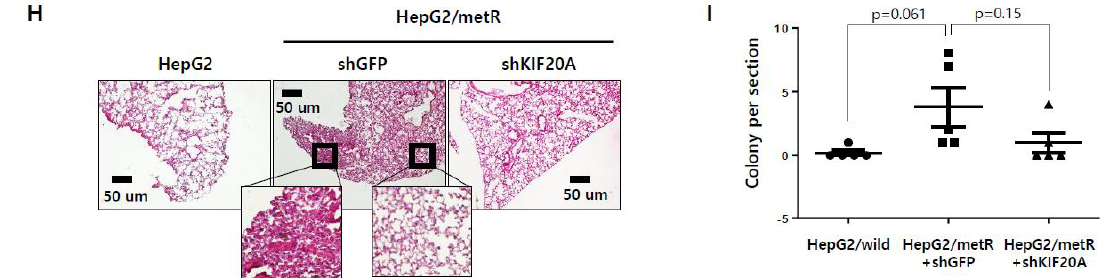
Figure 5. Lactate-induced cell motility is closely associated with E2F1-mediated activation of kinesin family genes and regulation of microtubule dynamics. ( A ) E2F1-dependence of the mRNA expression of 5 different microtubule-associated kinesin family genes was quantitatively evaluated in control and E2F1-depleted HepG2/metR cells. For qRT-PCR the expression level of transcripts for each gene was normalized by Ct-value of EMC7. Results from three independent experiments are shown as mean ± SD. The p -value was assessed by Student’s t -test. * p < 0.05 and ** p < 0.01 vs. control. ( B ) Migration and invasion assays to examine the effects of kinesin family gene depletion on the motility of HepG2/metR cells. Original magnification (40 × ). ( C ) Immunofluorescence imaging of α -tubulin protein (green) to examine the effects of kinesin family gene depletion on the tubulin fiber structure in HepG2/metR cells. Experiments were conducted in triplicate, and the data shown represent a typical experiment. ( D ) Overall survival and disease-free survival rates of hepatocellular carcinoma patients depending on the combined expression of KIF2C, KIF18B, and KIF20A in TCGA-LIHC (372 patients) cohort. Hazard Ratios with 95% confidence interval are also shown. ( E ) Immunofluorescence imaging of α -tubulin protein (white) in HepG2/wild cells, and control siRNA-treated, KIF20A-depleted, or oxamate-treated HepG2/metR cells. Experiments were conducted in triplicates, and the data shown represent a typical experiment. ( F ) Correlation analysis between KIF20A expression levels and migration properties in eight different liver cancer cell lines. ( G ) Correlation analysis between KIF20A expression levels and lactate production rates in eight different liver cancer cell lines. The r- and p -values were assessed by Spearman correlation calculation. ( H ) H&E stained sections of lungs isolated from mice that received tail vein injection of HepG2/wild, HepG2/metR+shGFP, and HepG2/metR+shKIF20A cells (scale bar; 50 µ m). ( I ) Number of lung micrometastasis colonies per section in individual mice. Each data point represents the result for different mouse ( n = 5 mice per group). Imaging of H&E-stained tissues, and microscopic counting of colonies were done using AlphaEaseFC program (area size 225 µ m 2 ). Error bars represent standard deviation; statistical analysis was performed using ANOVA test.